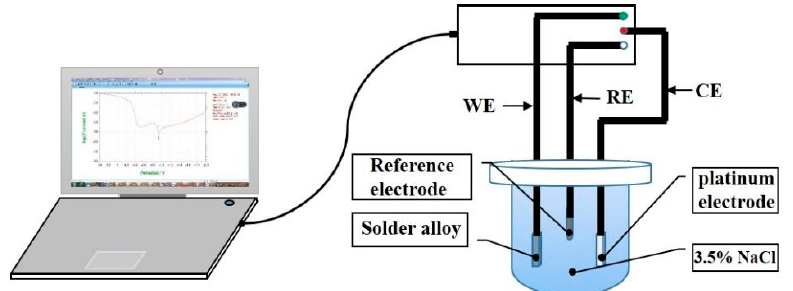
Figure 1. Schematic diagram of the classic three-electrode